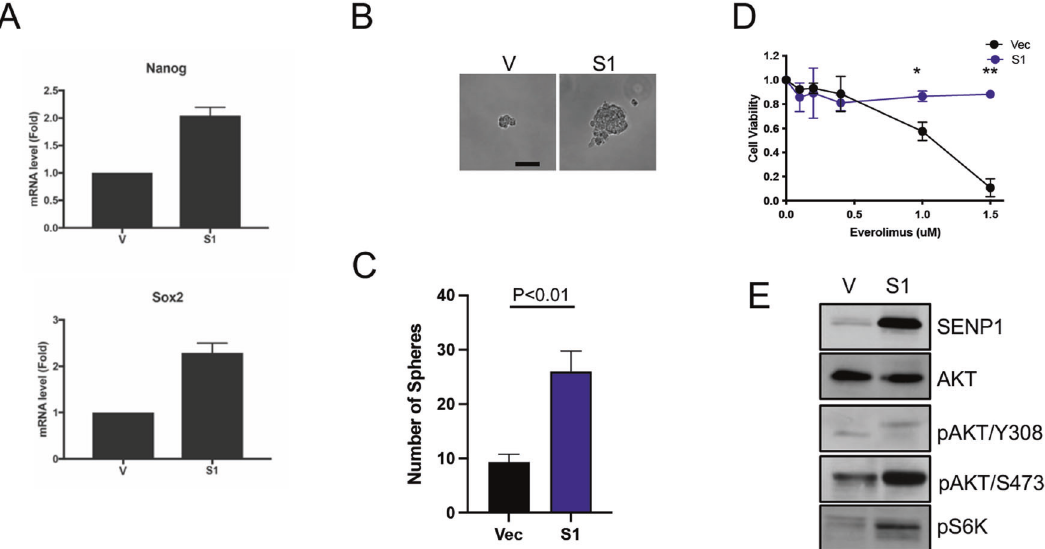
Fig. 6 SENP1 overexpression increases the stemness of ccRCC cells and confers resistance to mTOR inhibition. A Messenger RNA levels for Nanog (upper) and Sox2 (lower) were measured by qRT-PCR in control (V) and SENP1 overexpressing 786-O cells (S1#7) and plotted. 200 cells of control (V) or SENP1-expressing clone (S1#7) were seeded on low attachment plates in sphere-forming assay media. After 14 days, representative pictures of the spheres were taken ( B ) and the number of spheres were counted in three replicas of three independent experiments ( C ). D Luciferase-expressing 786-O cells (vector and S1#7) were exposed to increasing doses of everolimus for 24 h, and the luciferase activity in the remaining viable cells was measured by a luminometer. E 786-O cells (vector and S1#7) cells were analyzed by immunoblotting using the indicated